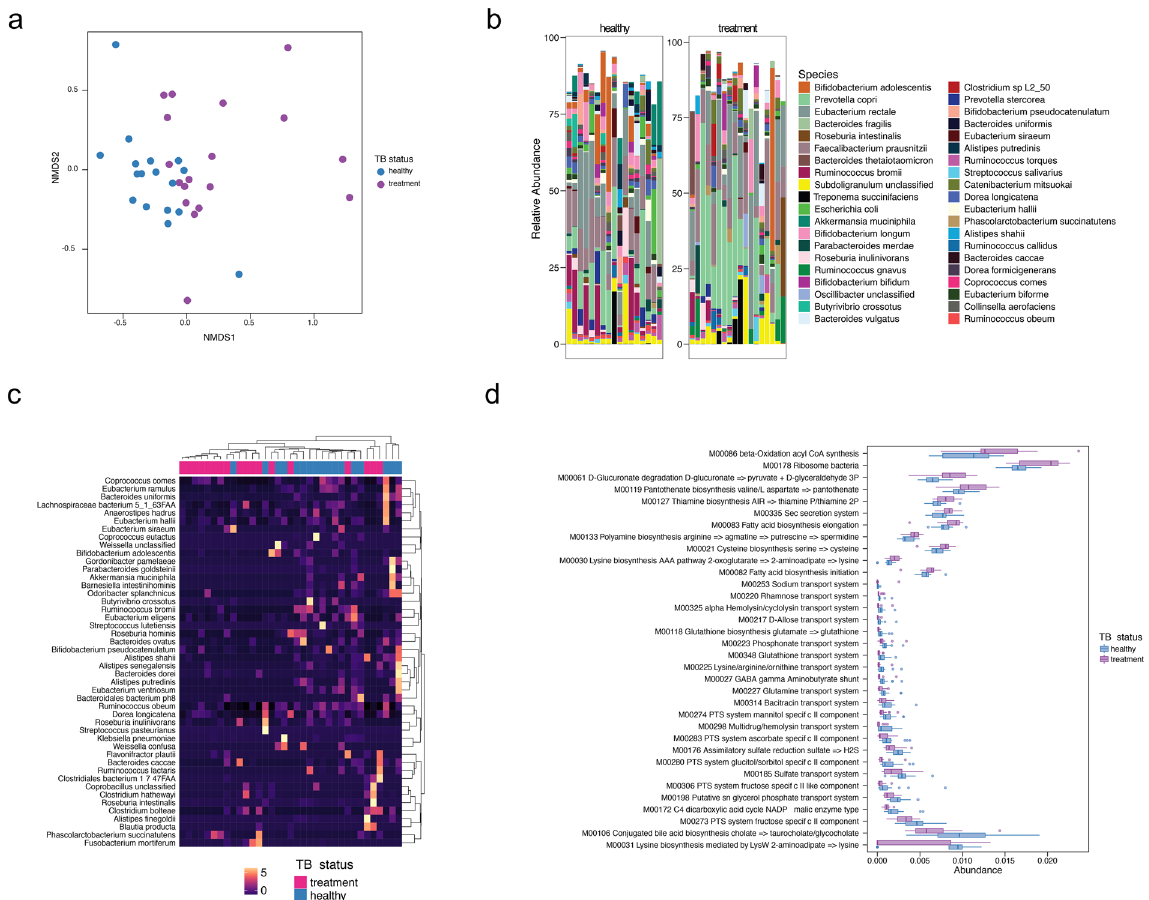
Figure 3. Taxonomic and biochemical microbiomic perturbation induced by HRZE. ( a ) NMDS ordination plot on metagenomic taxonomy data demonstrating microbiomic differences between healthy individuals and subjects on HRZE treatment. For this comparison, the healthy group consists of LTBI and Mtb uninfected subjects. (b) Comparative abundance plots between healthy Haitian individuals and cases on HRZE treatment showing the most abundant species. ( c ) Unsupervised hierarchical clustering of significantly altered taxa from species-level metagenomic data. ( d ) Abundance of significantly different KEGG modules between healthy volunteers and cases on